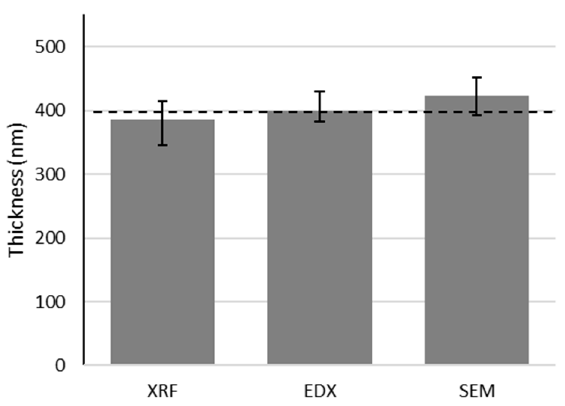
Figure 5. XRF, EDX and SEM thickness measurement of galvanized sample. The dotted line shows the average thickness of 399 nm.